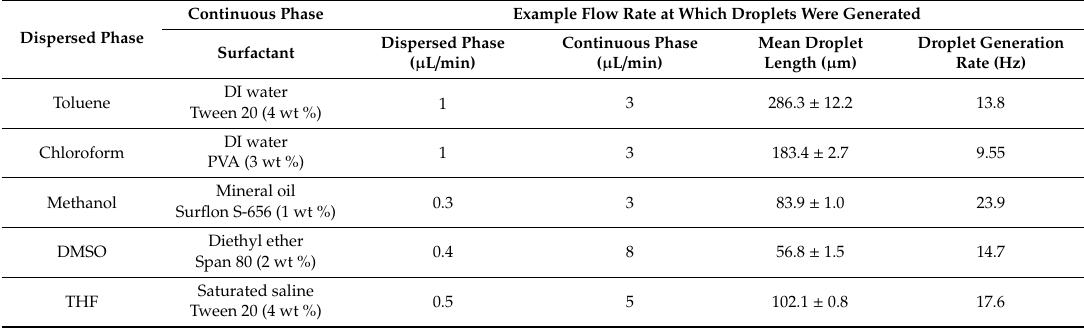
Figure 2. Image showing the laminar flow of toluene in the absence of surfactant. The flow rates of the dispersed and continuous phases (µL/min) were 1 and 3, respectively. The magnification of microscope was 10×. Table 1. Typical flow conditions for generating droplets of five typical organic solvents and their carrier combinations. The sample size of the mean droplet length measurement was 30 droplets.